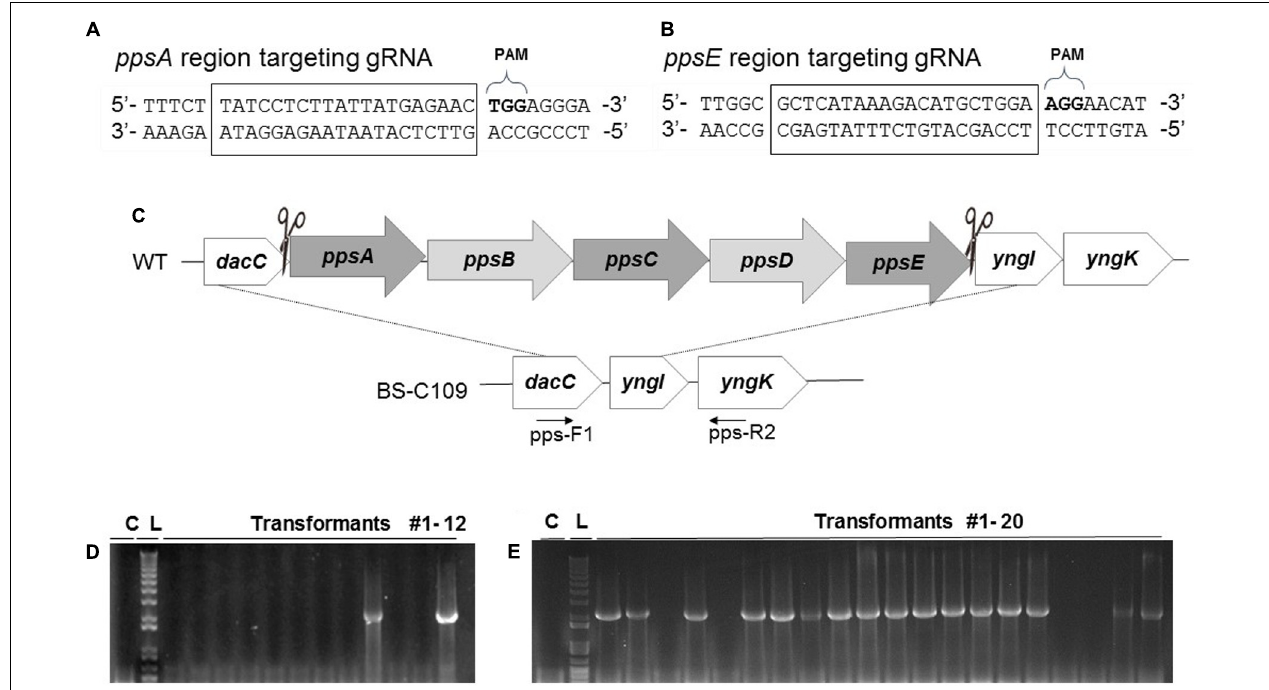
FIGURE 3 | Construction of the pps operon ( ppsABCDE ) deletion mutation and its efficiency. (A) ppsA and (B) ppsE -targeting multiple gRNA sequences. All the squared 20 bp nucleotides were used as gRNA binding sites. (C) After DSBs occurred in ppsA and ppsE , double crossover at the dacC and yngK initiated to eliminate the pps operon (38 kb). Deletion was confirmed with PCR using two primers, pps-F1 and pps-R2. (D) Without prolonged incubation the pps operon deletion mutation was 16.7% efficient. (E) Prolonged incubation under selective pressure increased the mutation efficiency to 80%.